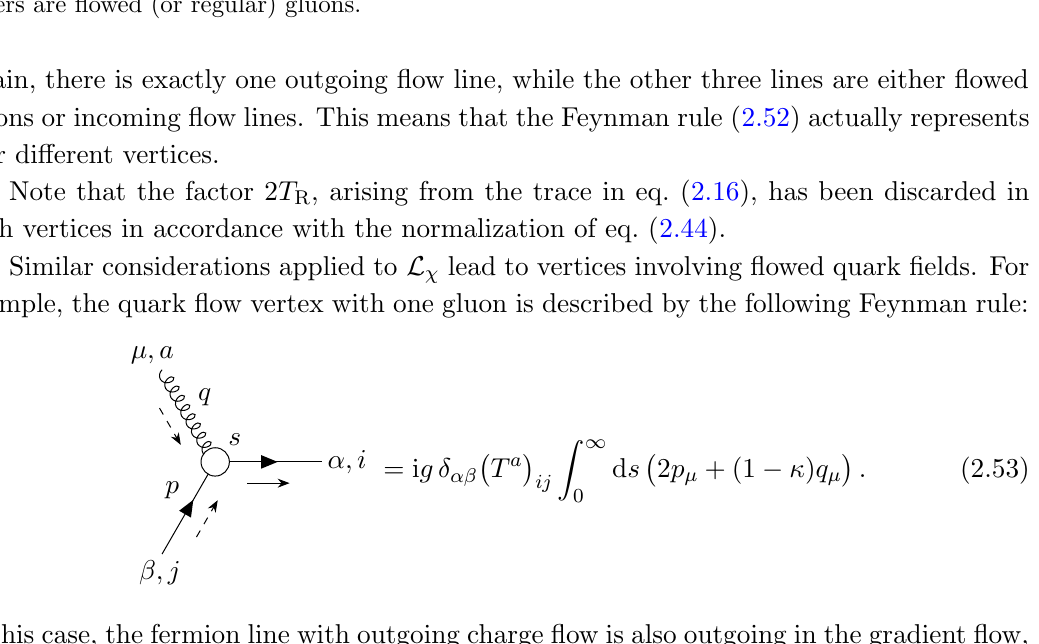
2 . Lines with an adjacent arrow denote (cid:13)ow lines, the